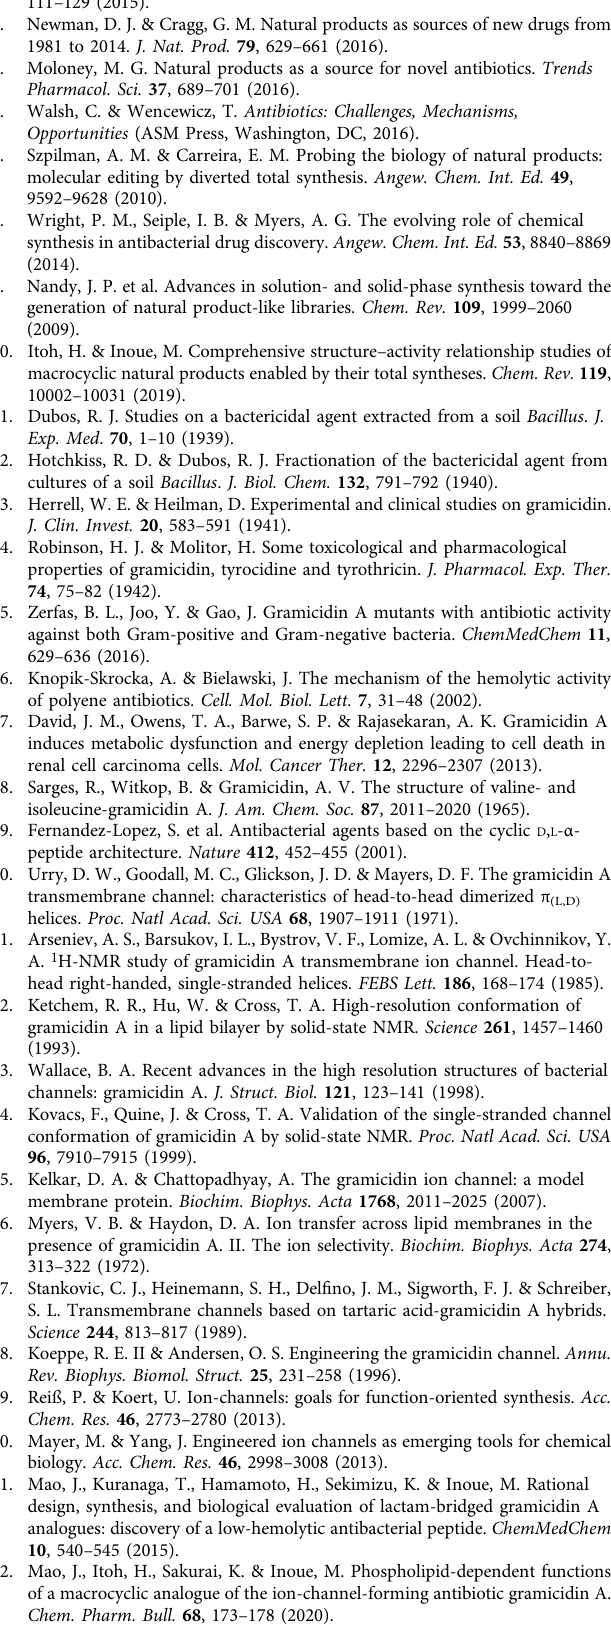
Figs. 45 – 63. For UHPLC charts of puri fi ed synthetic compounds, see Supple- mentary Figs. 64 – 74. For MS spectra of 593 bead-derived peptides, see Supple- mentary Figs. 75 – 173. For mean IC 50 values with SDs in the mammalian cytotoxicity assay and mean EC 50 values with SDs in the H + /Na + transport assay, see Supplementary Table 14. For MIC values ( μ g/mL) against six bacterial strains, see Supplementary Table 15. For experimental procedures and spectroscopic data of compounds, see Supplementary